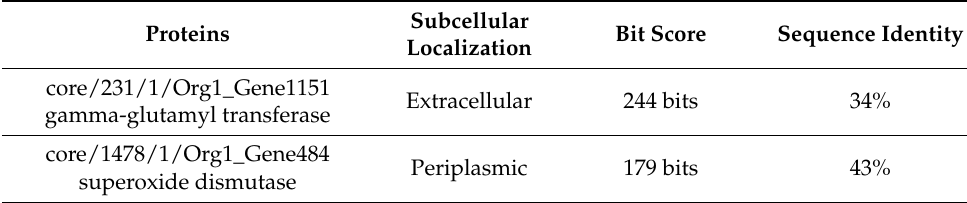
Table 2. From the exposed proteins, virulent proteins were identified. Subcellular Bit Score Sequence Identity Proteins Localization